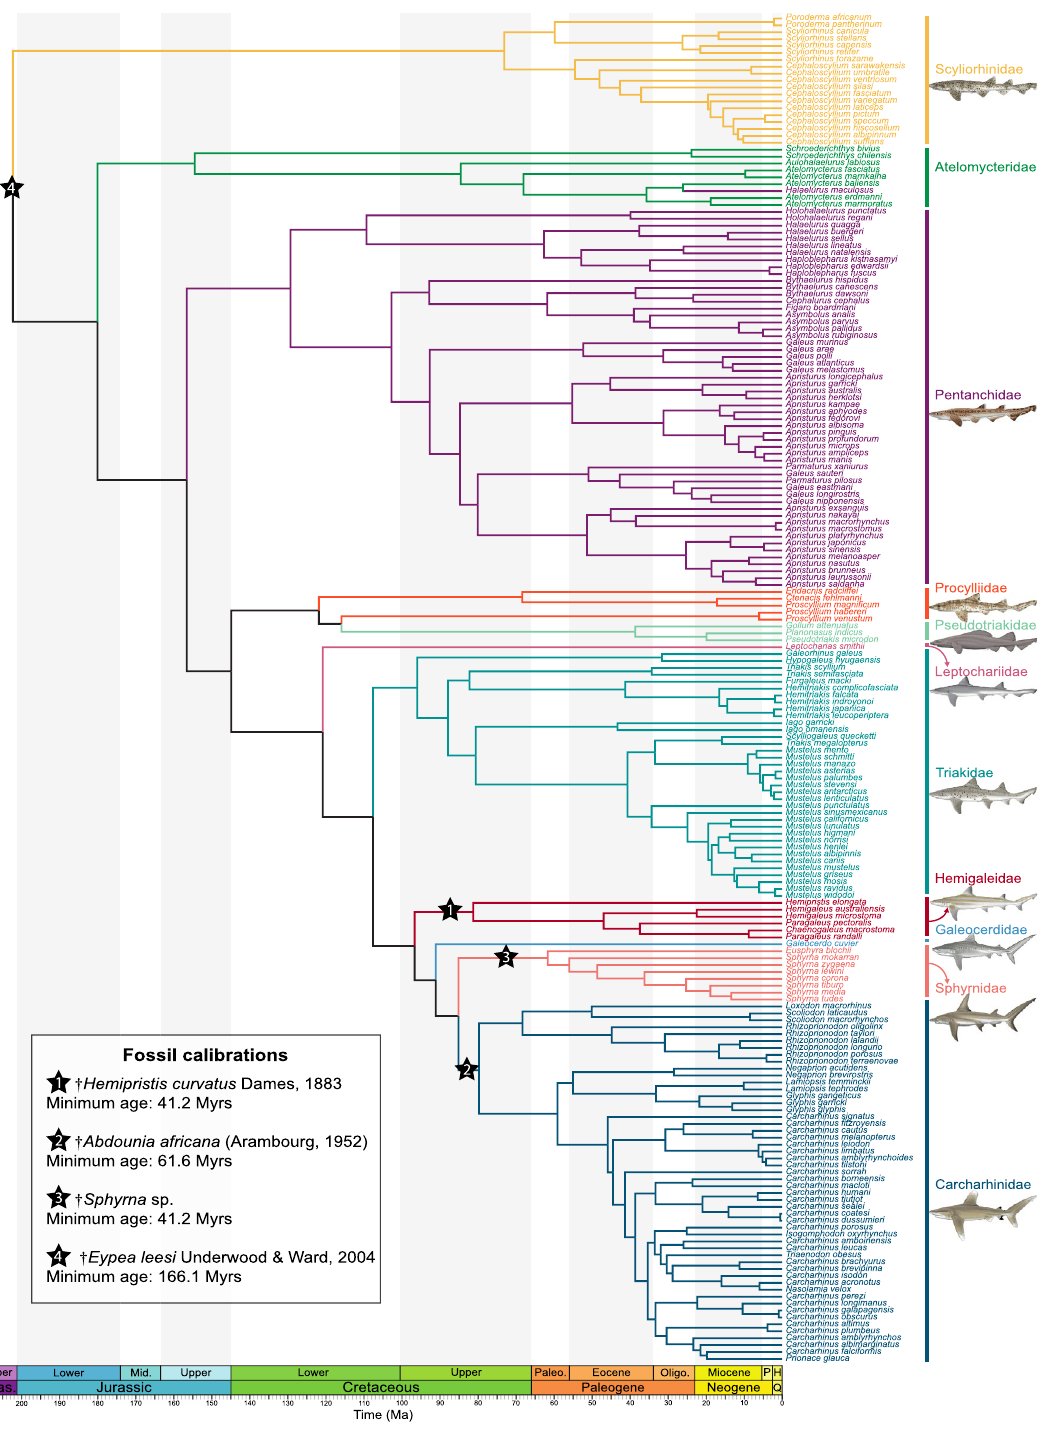
Figure 4. Bayesian time-calibrated phylogeny of Carcharhiniformes and evolution of reproductive strategies and habitats through time. The phylogeny of ground sharks has been reconstructed with 13 mitochondrial protein-coding genes, two mitochondrial RNA genes, and one nuclear protein-coding gene divided into 7 molecular partitions. The divergence times have been estimated using 7 fossil calibrations with uniform priors and 4 molecular clocks (for sensitivity phylogenetic analyses, see Supplementary Data S11). Branches show the carcharhiniform families. Shark images courtesy of Marc Dando